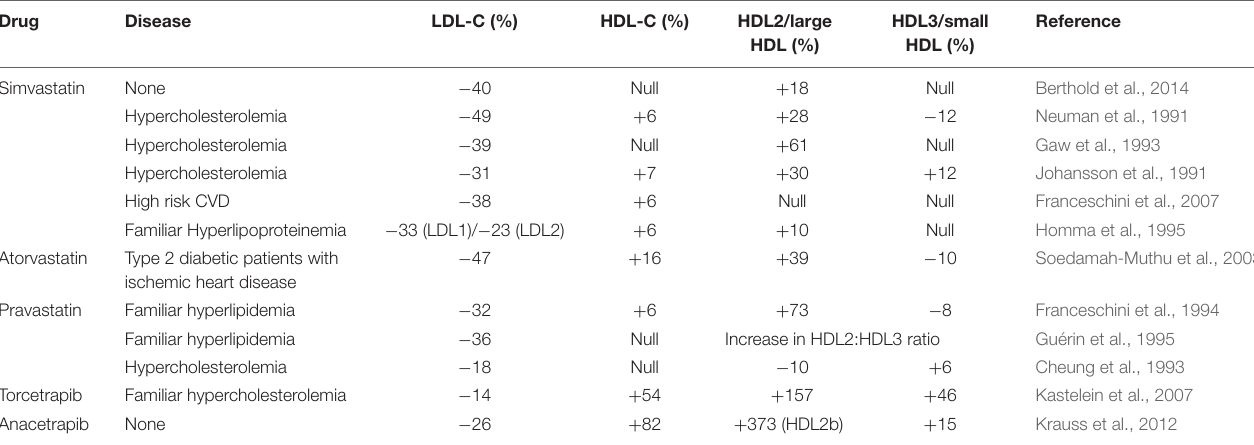
TABLE 2 | Impact of statin and CETP inhibitor therapy on patient lipid profile.